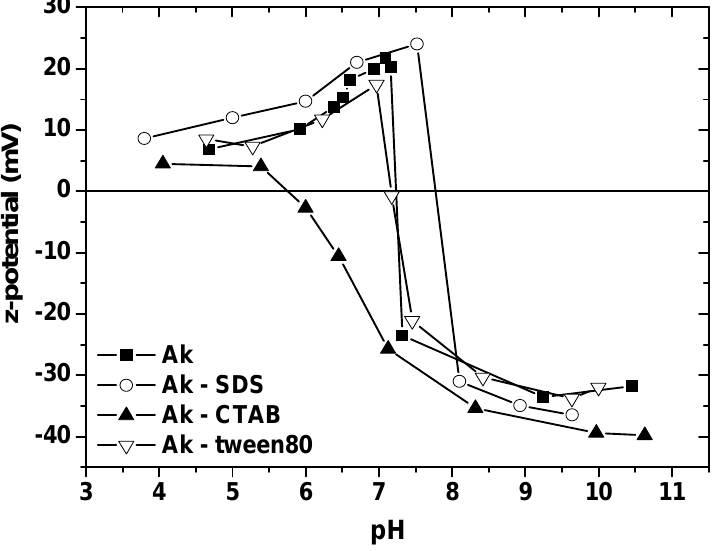
Figure 3. Electrokinetic measurements, expressed as zeta-potential, of the akaganeite after surfactants adsorption as a function of solution